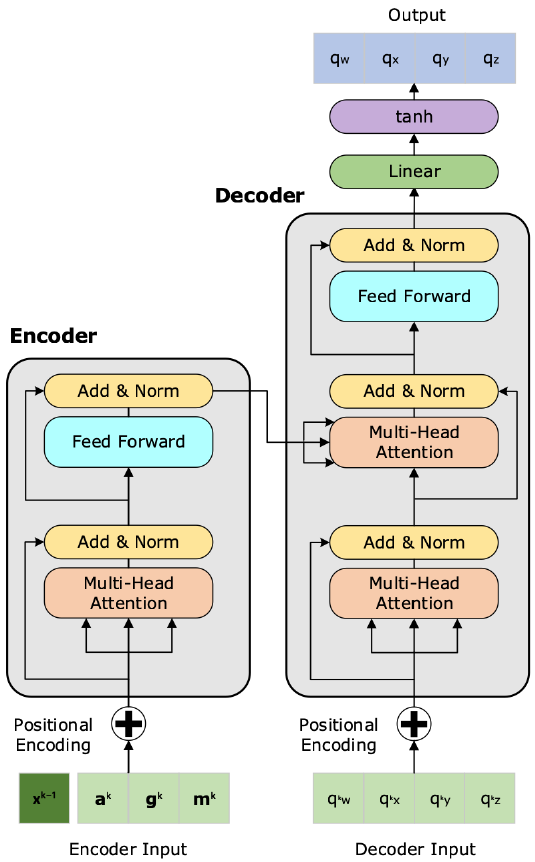
Figure 1. Attformer/UKF–Attformer Structure. The Attformer was trained solely with the in- put features of the raw three-axis measurements from the accelerometer (Equation (3)), gyroscope (Equation (1)) and magnetometer (Equation (4)). The UKF–Attformer was trained with the additional input feature of the prior UKF attitude estimate from Section